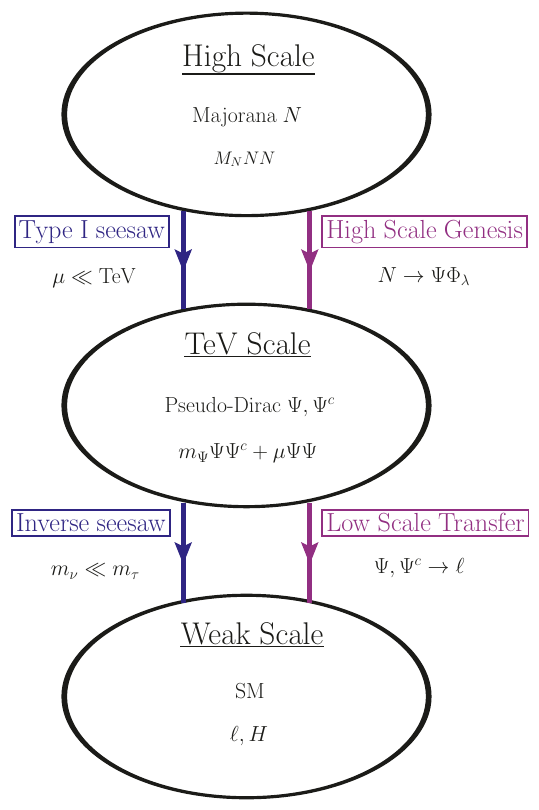
Figure 1 . Schematic representation of physics (seesaw and genesis) of the hybrid